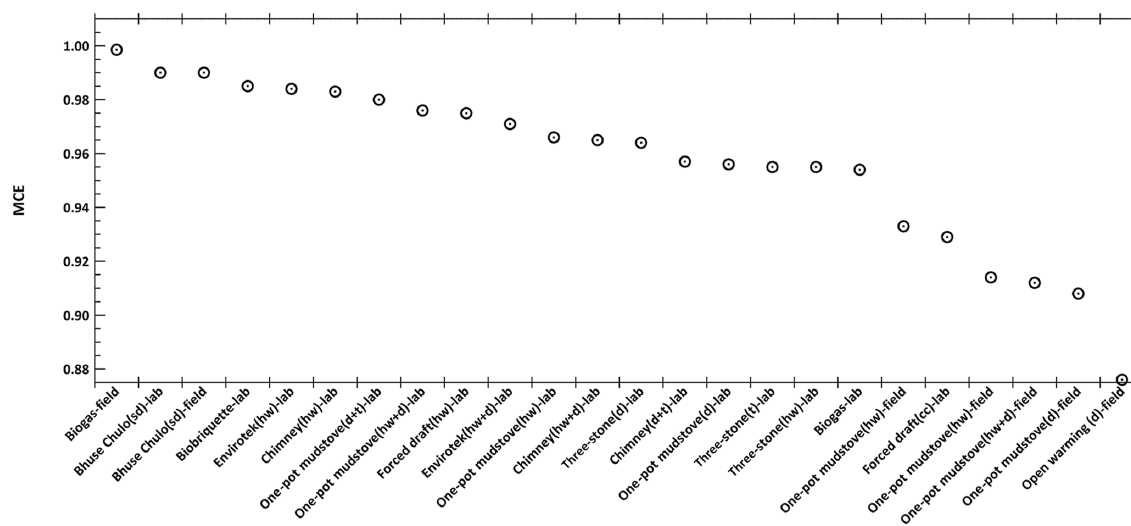
Figure 3. The modified combustion efficiency (MCE) shown in descending order for each cookstove–fuel combination measured in this study. The stove type is listed followed by the main fuel constituents and an indication whether the source was a lab or field measurement. Note: “hw” indicates hardwood fuels; “d” indicates dung; “cc” indicates charcoal; “t” indicates twigs; and “sd” indicates